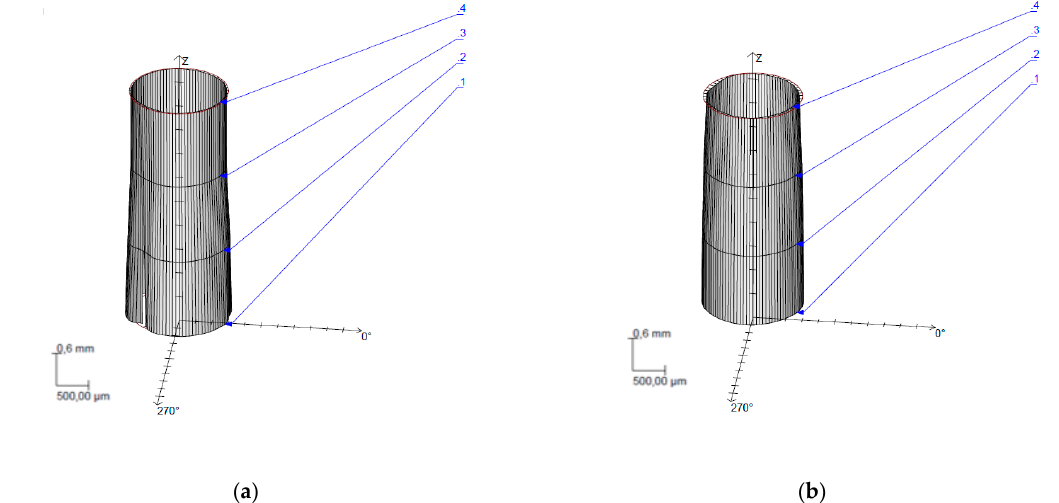
Figure 16. Cylindricity deviations. Test 11. WP = 1200 bar, TFR = 45 mm/min and AMFR = 170 gr/min for: ( a ) UNS A97075/CFRP configuration; ( b ) CFRP/UNS A97075 configuration.